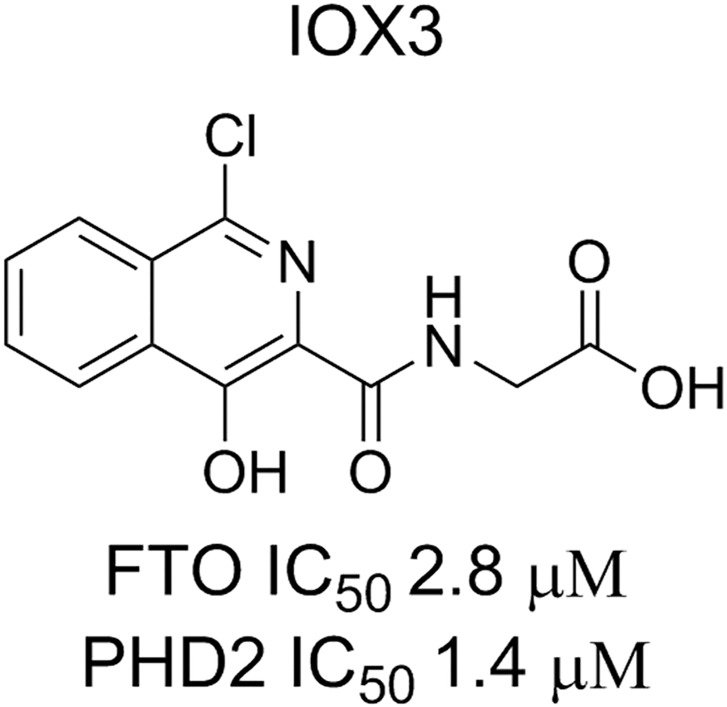
Chemical structure of IOX3 and IC50 values for FTO and PHD2.